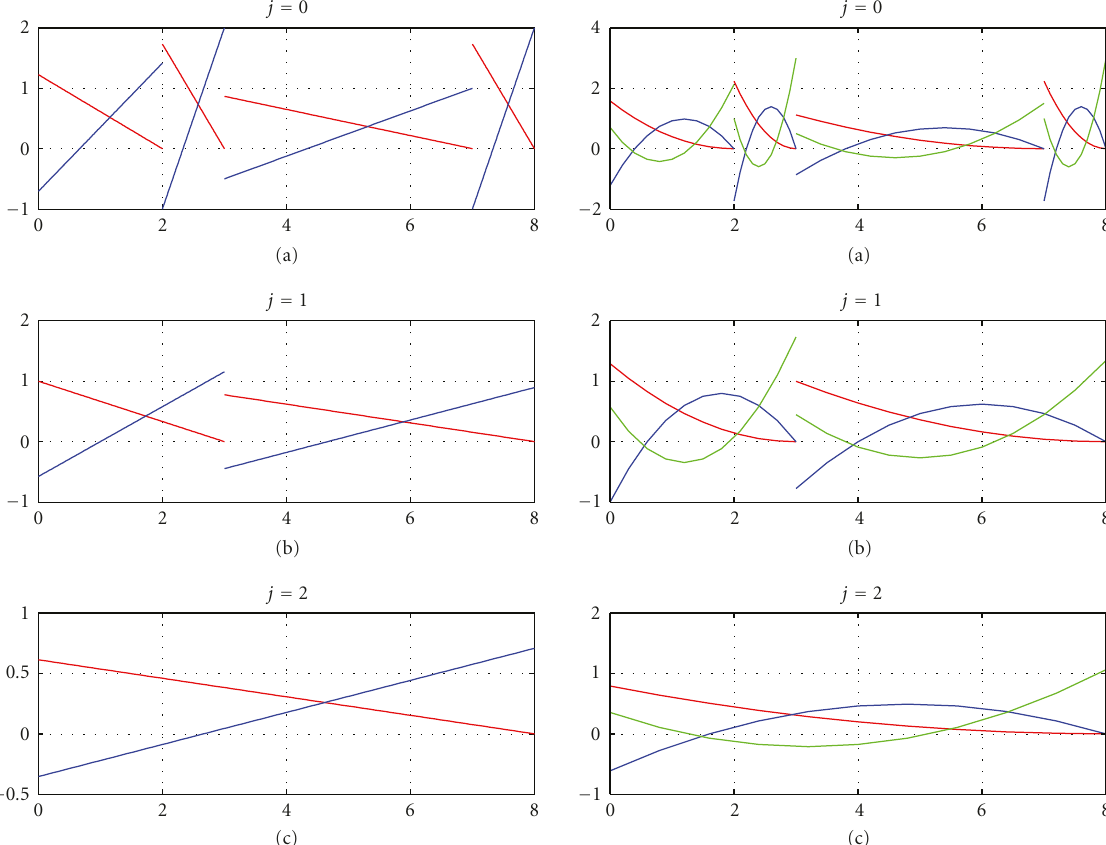
Figure 2: Orthonormal linear (left graphs) and quadratic (right graphs) piecewise polynomial scaling functions at j =